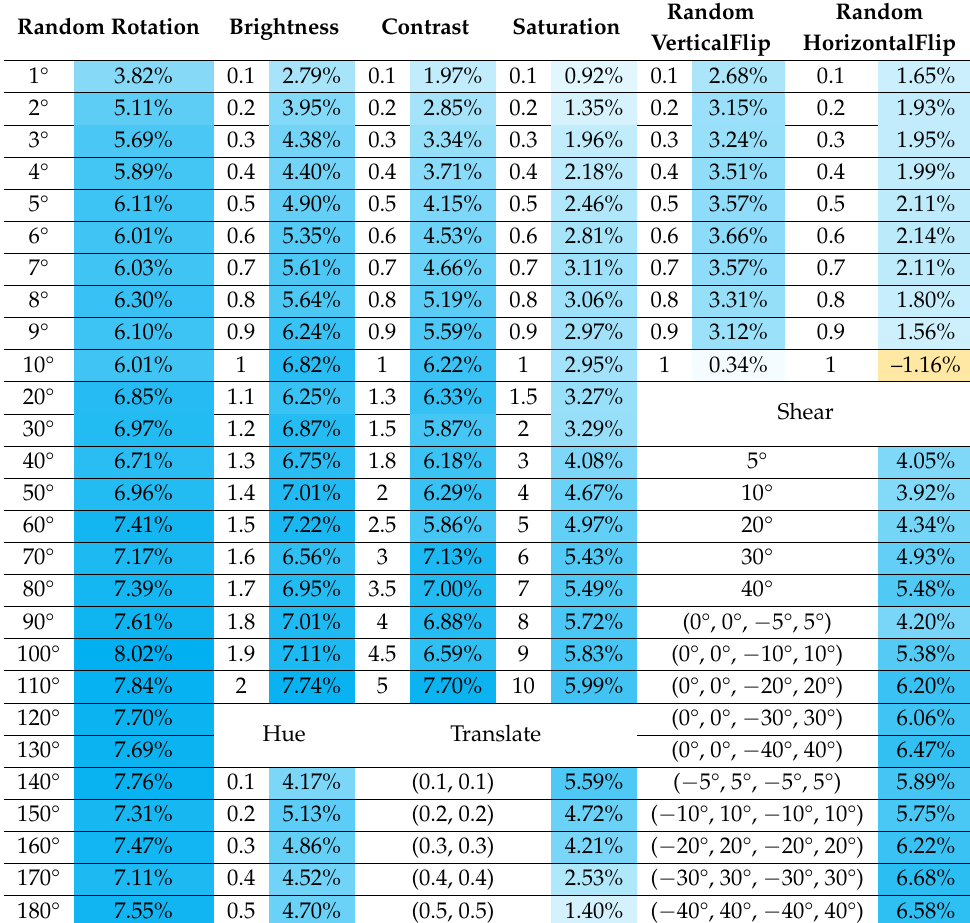
Table 4. Performance of DA methods on Γ train 50 . The impact of DA methods and parameters on PAP classification performance for Γ train 50 is revealed. The displayed percentage values describe the PAP increase/decrease of mAA in percent. The value is color-coded from blue (increase in accuracy) over white (no effect) to orange (decrease in